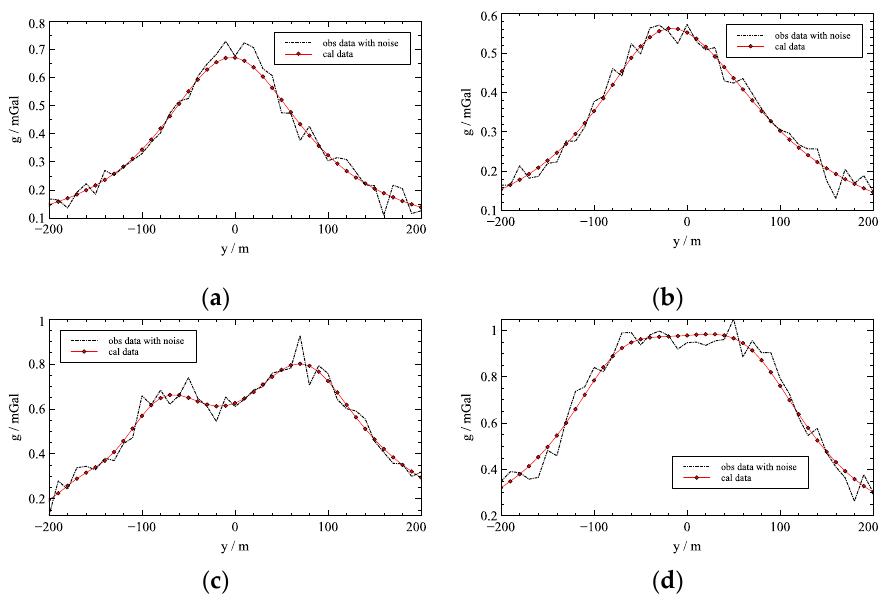
Figure 7. The observed data with noise and the model response for each model shown in Figure 2. ( a ) response of rectangular prism, ( b ) response of dipping prism, ( c ) response of parallel prism, ( d ) response of U prism.